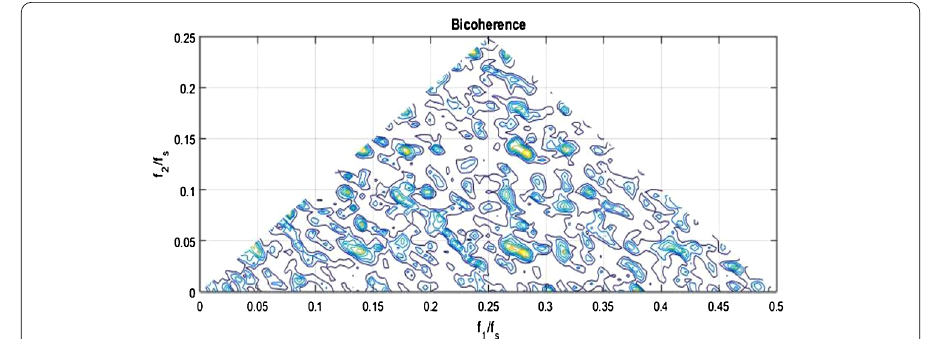
Figure 9 Bicoherence of the state x 3 of the fractional-order